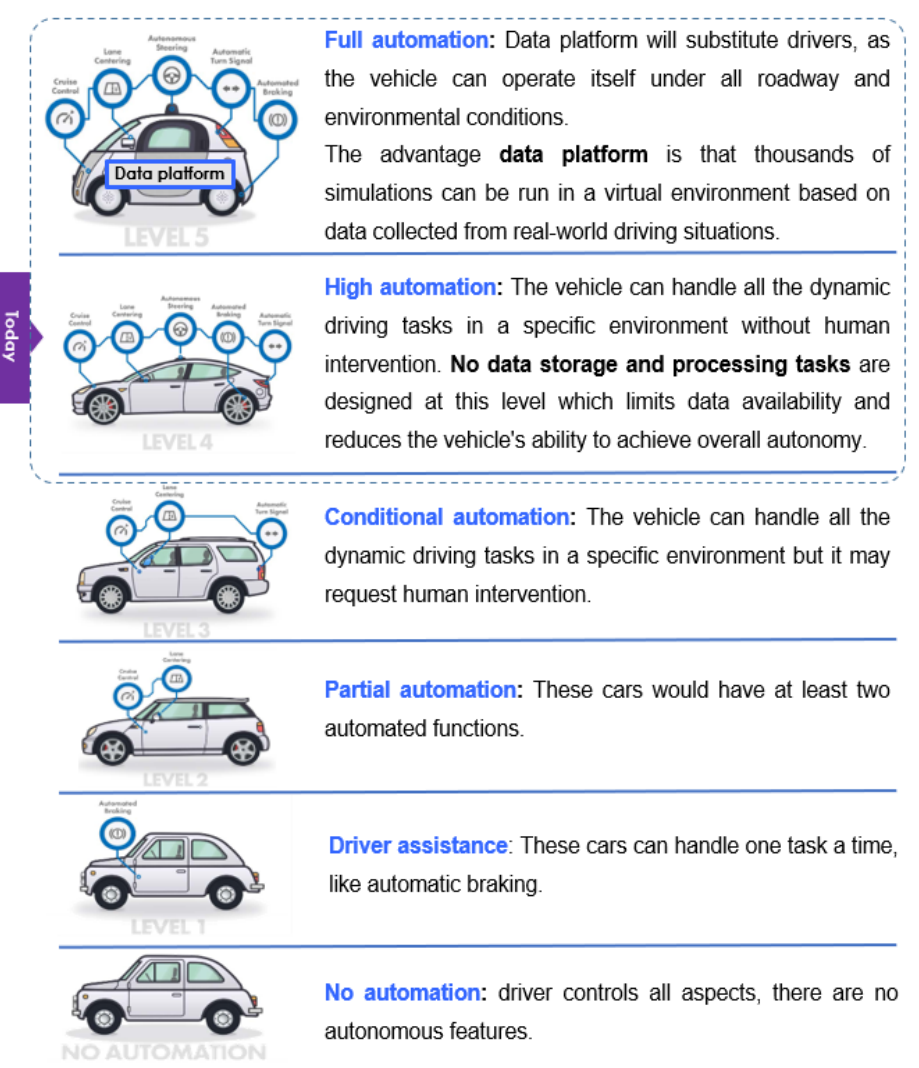
Figure 1. Levels of autonomy and data